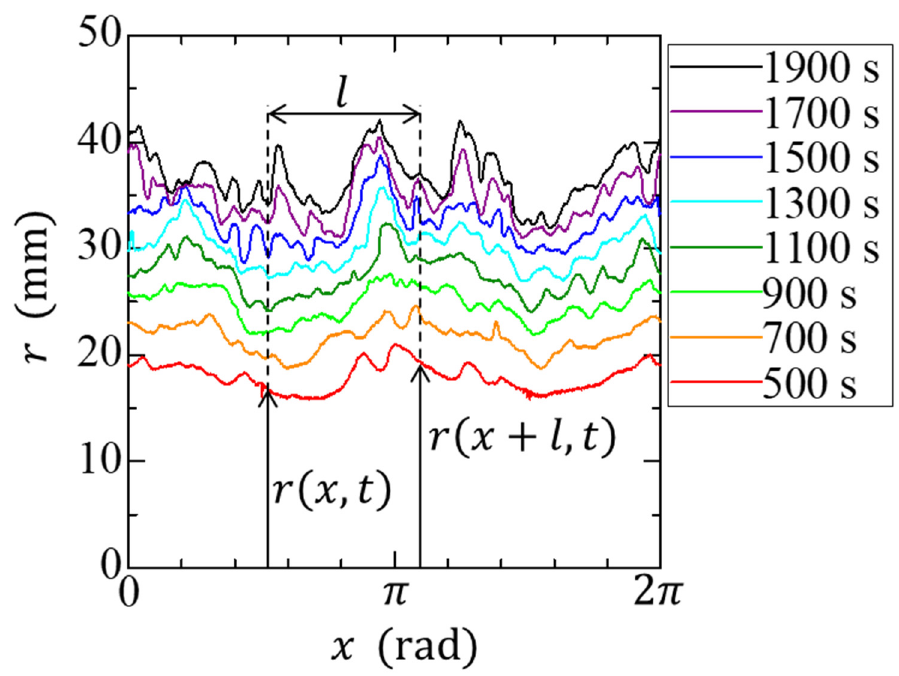
Figure 3. Example of the time evolution of the interface at 𝑡 = 500–1900 s. The value 𝑙 is determined by 𝑟 and 𝑥 and has the unit of rad